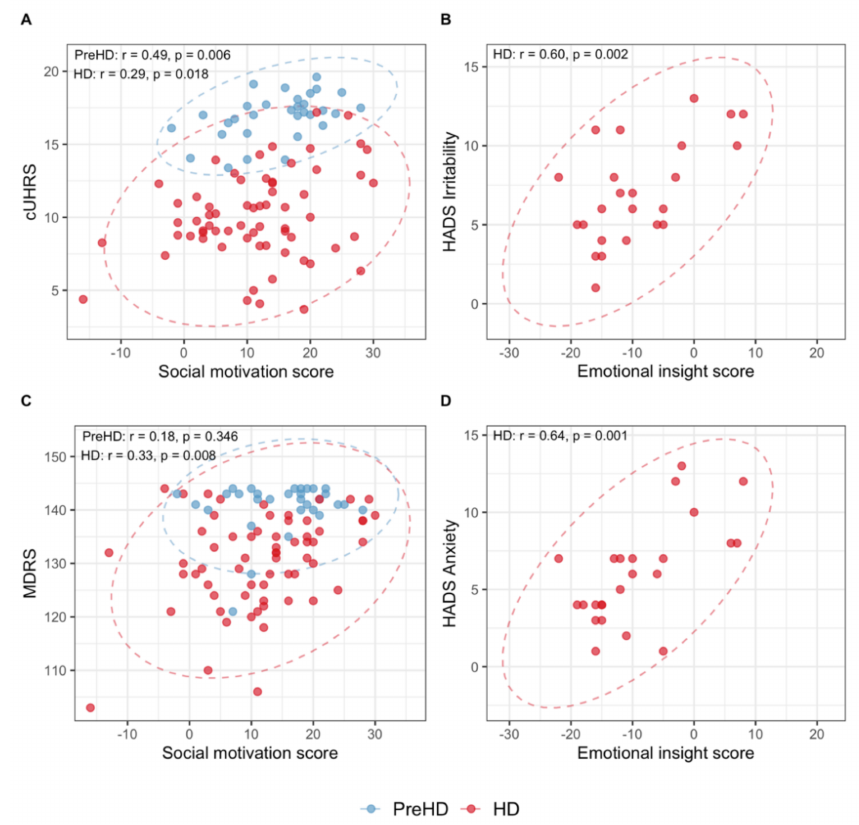
Figure 2. Relationships between SRSQ domains and clinical assessments: ( A ) social motivation and cUHDRS; ( B ) emotional insight and HADS Irritability; ( C ) social motivation and MDRS; ( D ) emotional insight and HADS Anxiety. Abbreviations: PreHD = presymptomatic stage, HD = Huntington’s Disease, cUHDRS = Composite Unified Huntington’s Disease Rating Scale, HADS = Hospital Anxiety and Depression Scale, MDRS = Mattis Dementia-Rating